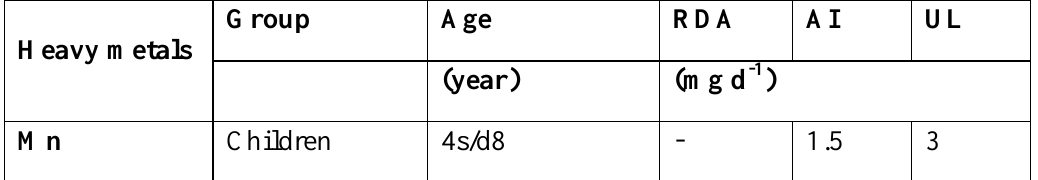
Table 5. The recommended daily allowance (RDA), allowable intake (AI) and upper limits (UL) of the studied heavy metals denuding people group and